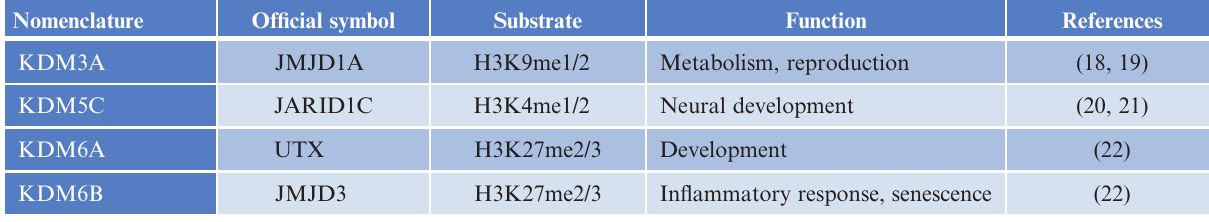
Table 1. Histone demethylases implicated in